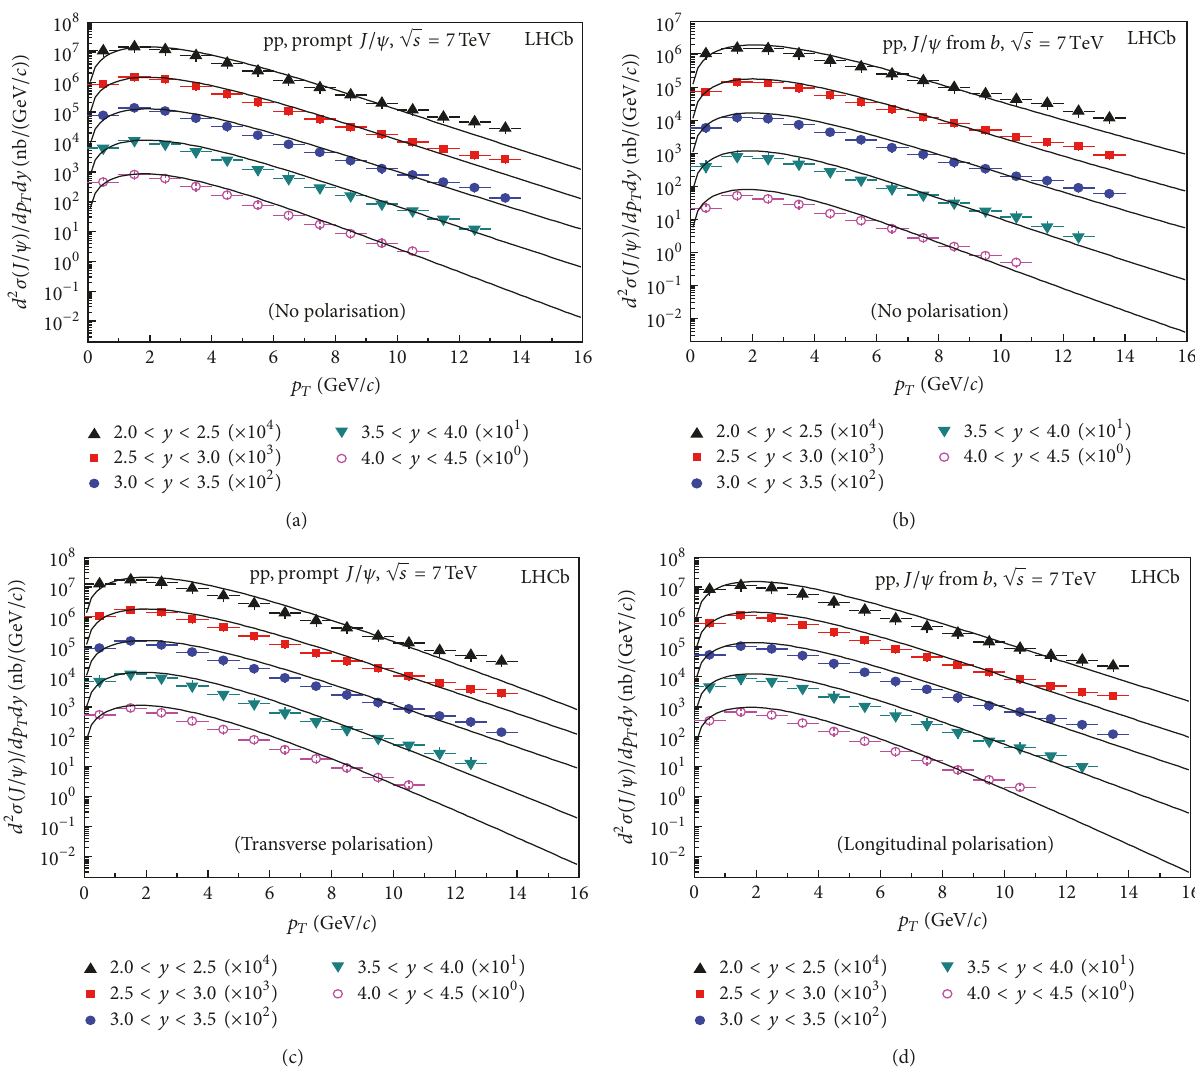
Figure 1: Double-differential cross section 𝑑 2 𝜎/𝑑𝑝 𝑇 𝑑𝑦 as a function of 𝑝 𝑇 in bins of 𝑦 for (a) prompt 𝐽/𝜓 with no polarisation, (b) 𝐽/𝜓 from 𝑏 with no polarisation, (c) prompt 𝐽/𝜓 with full transverse polarisation, and (d) prompt 𝐽/𝜓 with full longitudinal polarisation in p-p collisions at √𝑠 NN = 7 TeV. The symbols indicate the experimental data of the LHCb Collaboration [15]. The solid lines indicate our theoretical